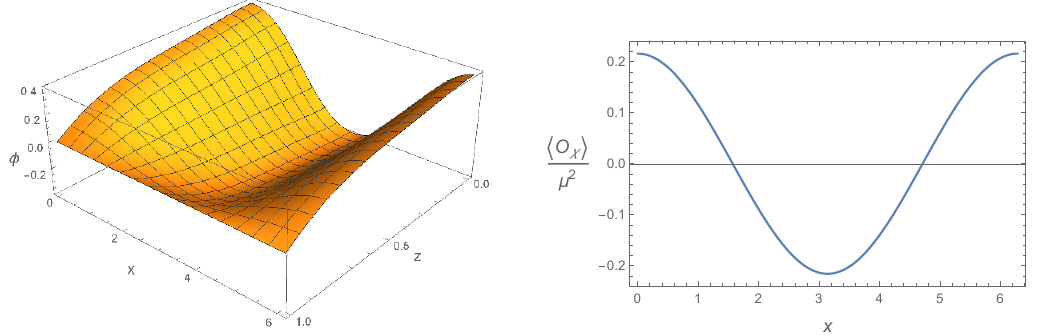
Figure 6 . Pro(cid:12)le for the scalar (cid:12)eld (cid:30) (left panel) and scalar VEV (right panel) for T = 0 : 01426 and k = 1, for the parameters chosen in (5.1) and q B = 0.